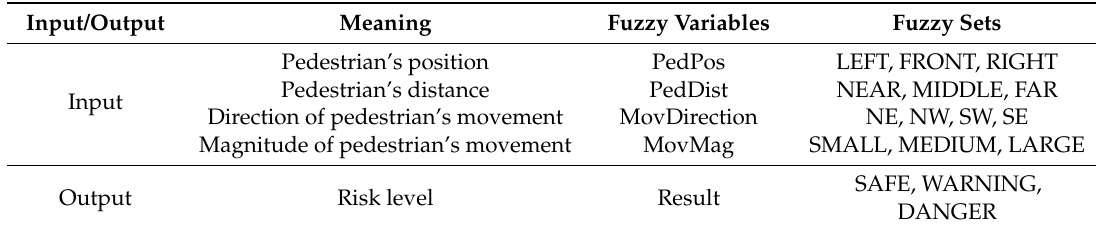
Table 1. Fuzzy variables and fuzzy sets.